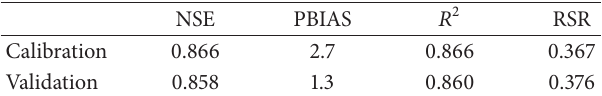
Table 3: The daily simulation results of the calibration and valida- tion